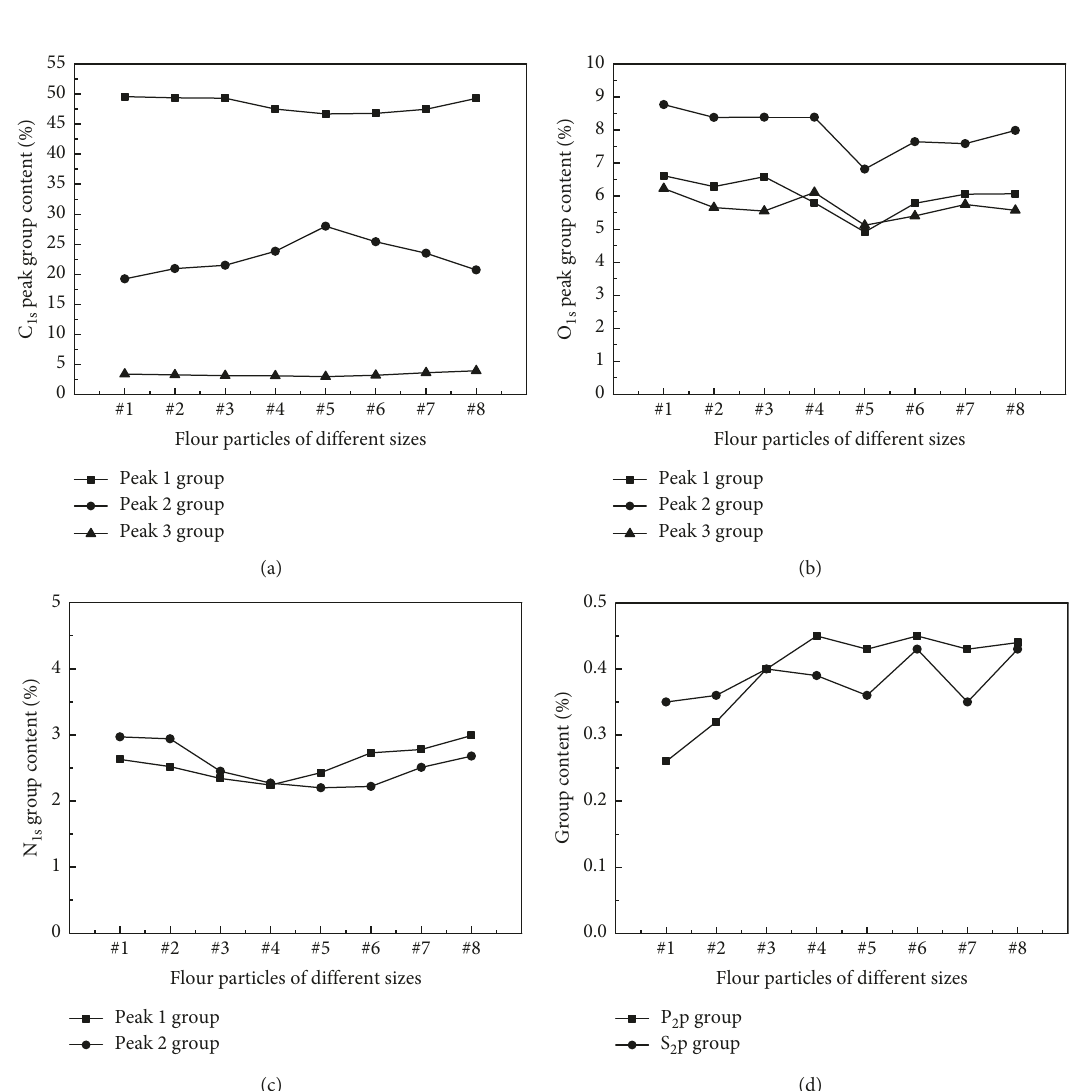
Figure 5: Variation of surface functional groups on the subpeaks of C 1s (a), O 1s (b), N 1s (c), P 2p , and S 2p (d) of flour particles of different